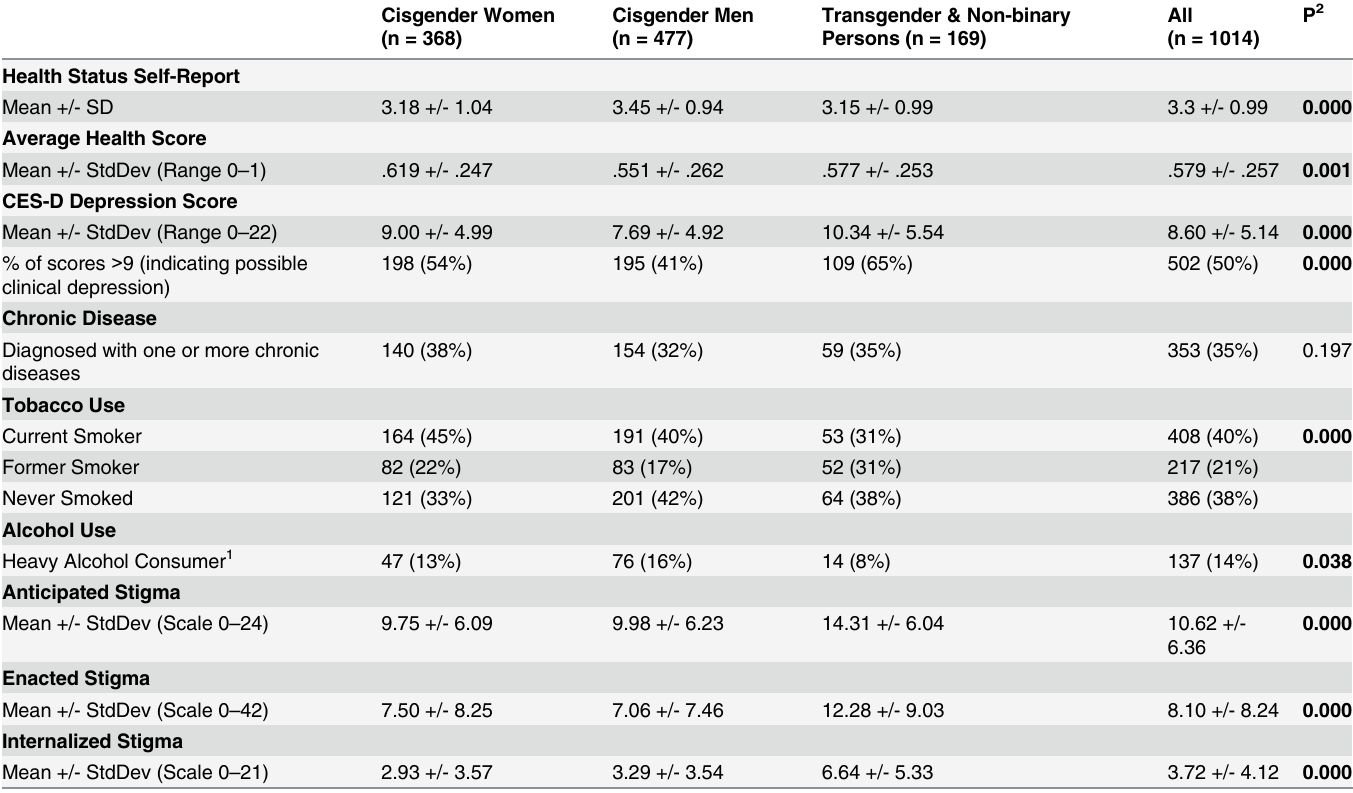
Table 3. Health Status and Risk Factors of an online sample of rural LGBT